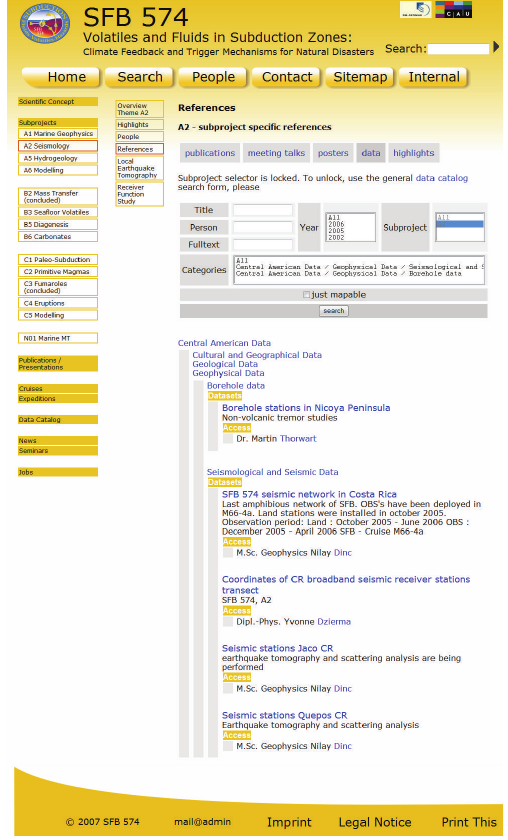
Figure 2: A subproject specific search form from the website of the “Collaborative Research Centre 574”, which serves as a portal for information about the scientific goals of the interdisciplinary projects, the available datasets, members and partners, and much more. References to publications, presentations, posters, or data are directly linked to subprojects, as seen in this screenshot. In the same way those items are linked to people, cruises, or areas—all relationships are driven by the PHPdbRelations system [17] and served by a MySQL database